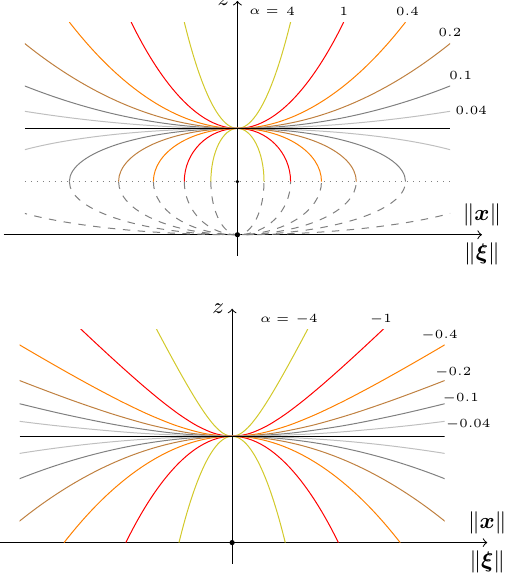
Figure 4. Transition from α = 4 to − 4 . Top: Transition from α = 4 to 0 . Bottom: Transition from α = 0 to − 4